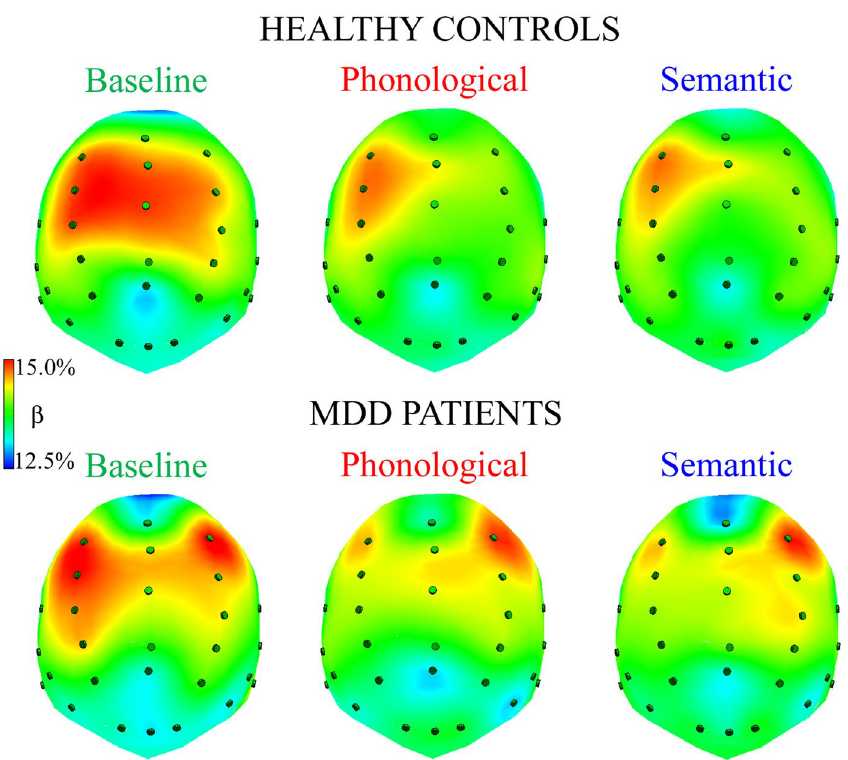
Figure 4. Spline maps of normalized beta amplitudes during resting state, baseline condition (left panel), phonological and semantic linguistic tasks (middle and right panels, respectively) for HC and MDD patients. Qualitative analysis of spline maps suggests that, compared with controls, depressed patients had lower levels of beta rhythm in anterior regions of the left hemisphere during the two linguistic tasks. In addition, controls showed an anterior, left-lateralized pattern of activation (i.e., higher percentages of beta band in anterior left vs. right regions) and a bilateral posterior activation in all